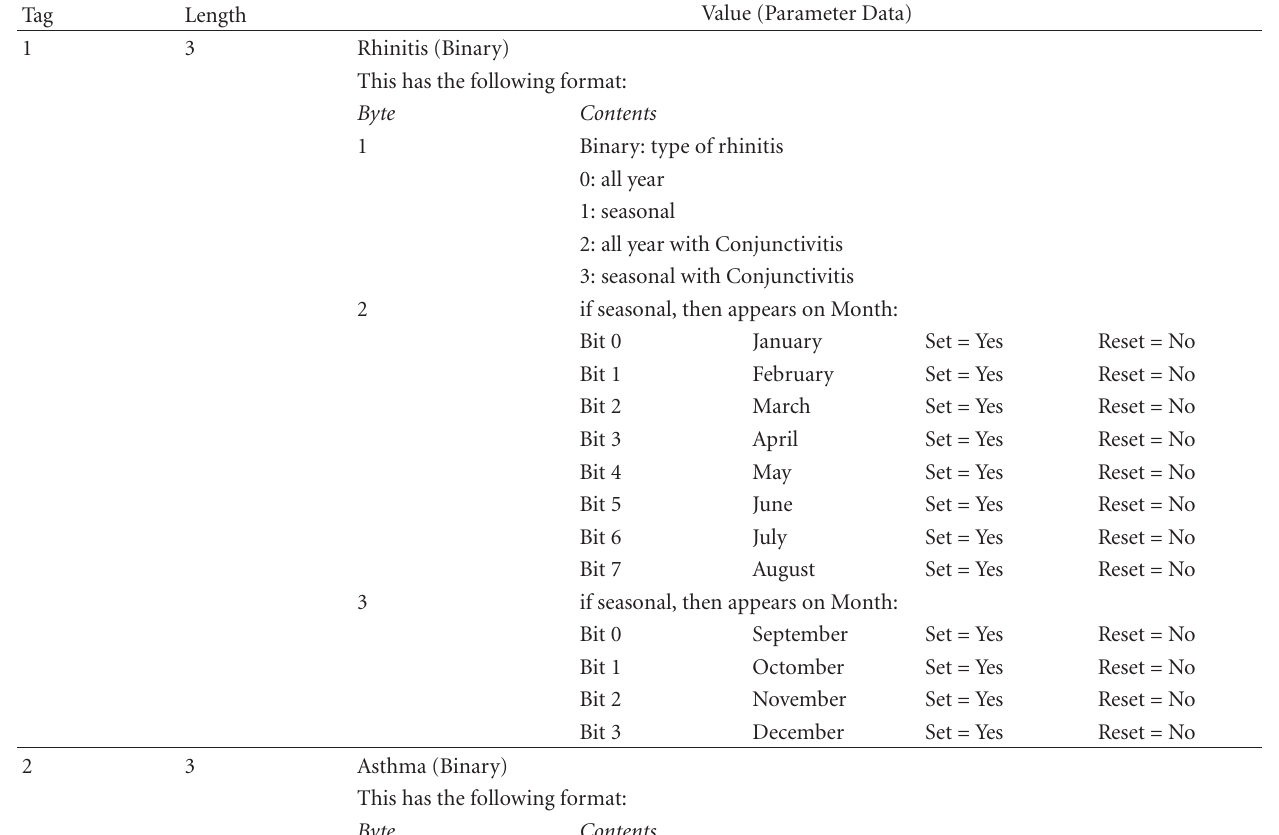
Table 4: Definition of Data Part of Section-204